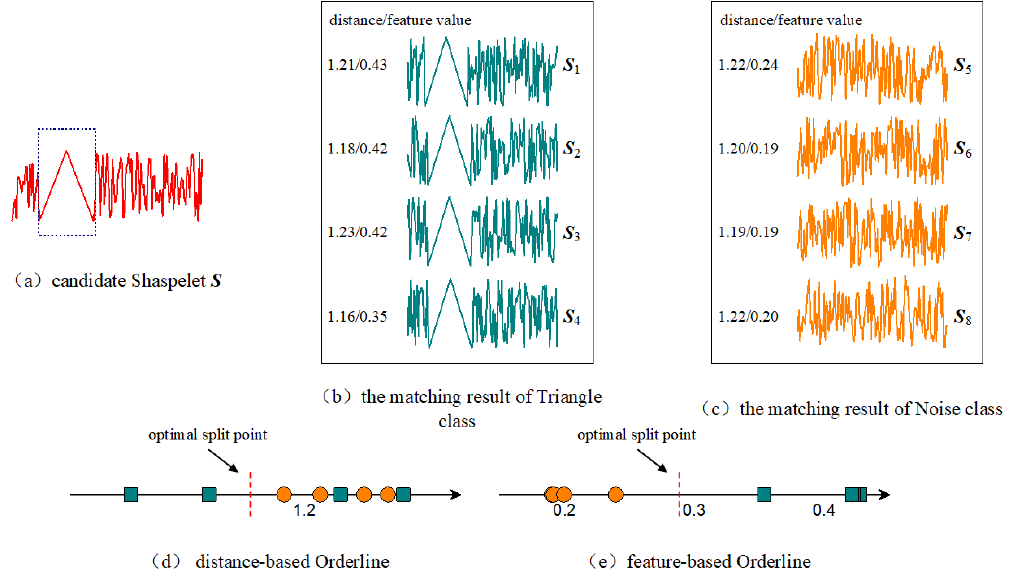
Figure 1. An example of mining discriminative information of subsequences via embedding canonical time series features.